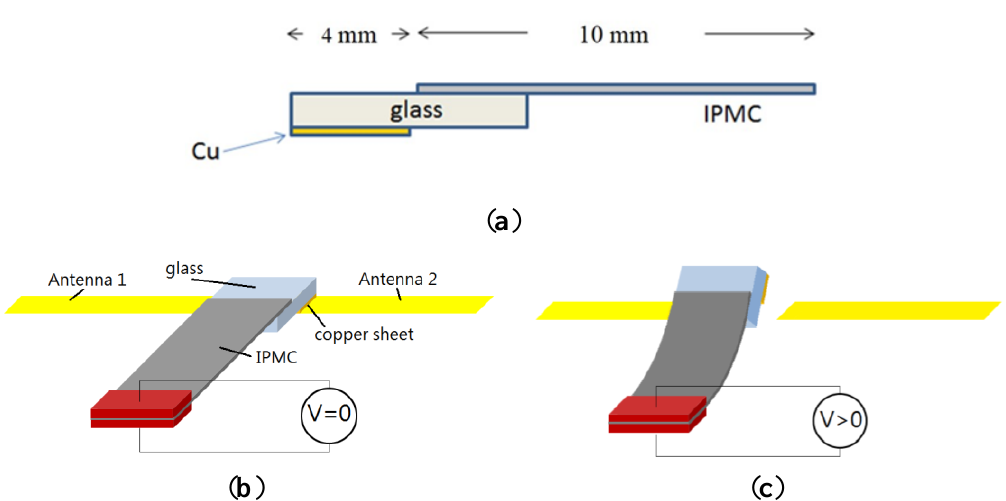
Figure 5. The illustration of normally-on IPMC switch design: ( a ) cross-section; ( b ) the on state ( V = 0) and ( c ) the off state ( V >